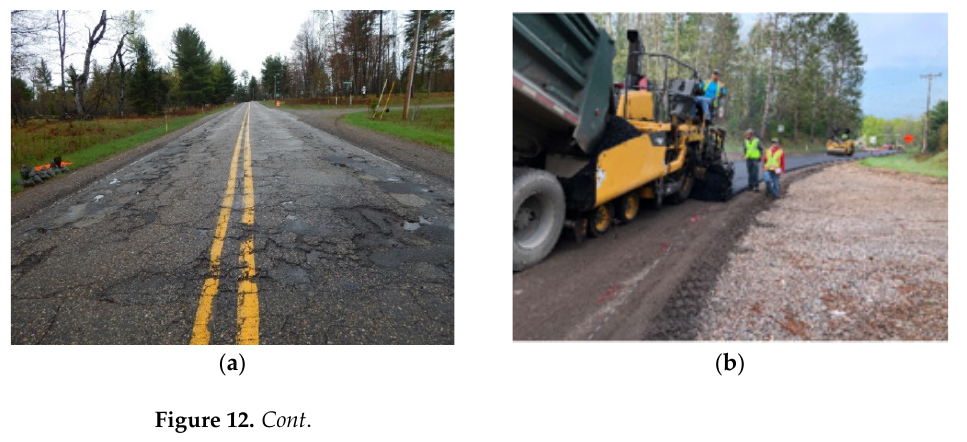
Table 7. Pavement M-E input for 19 mm-rubber-HMA.